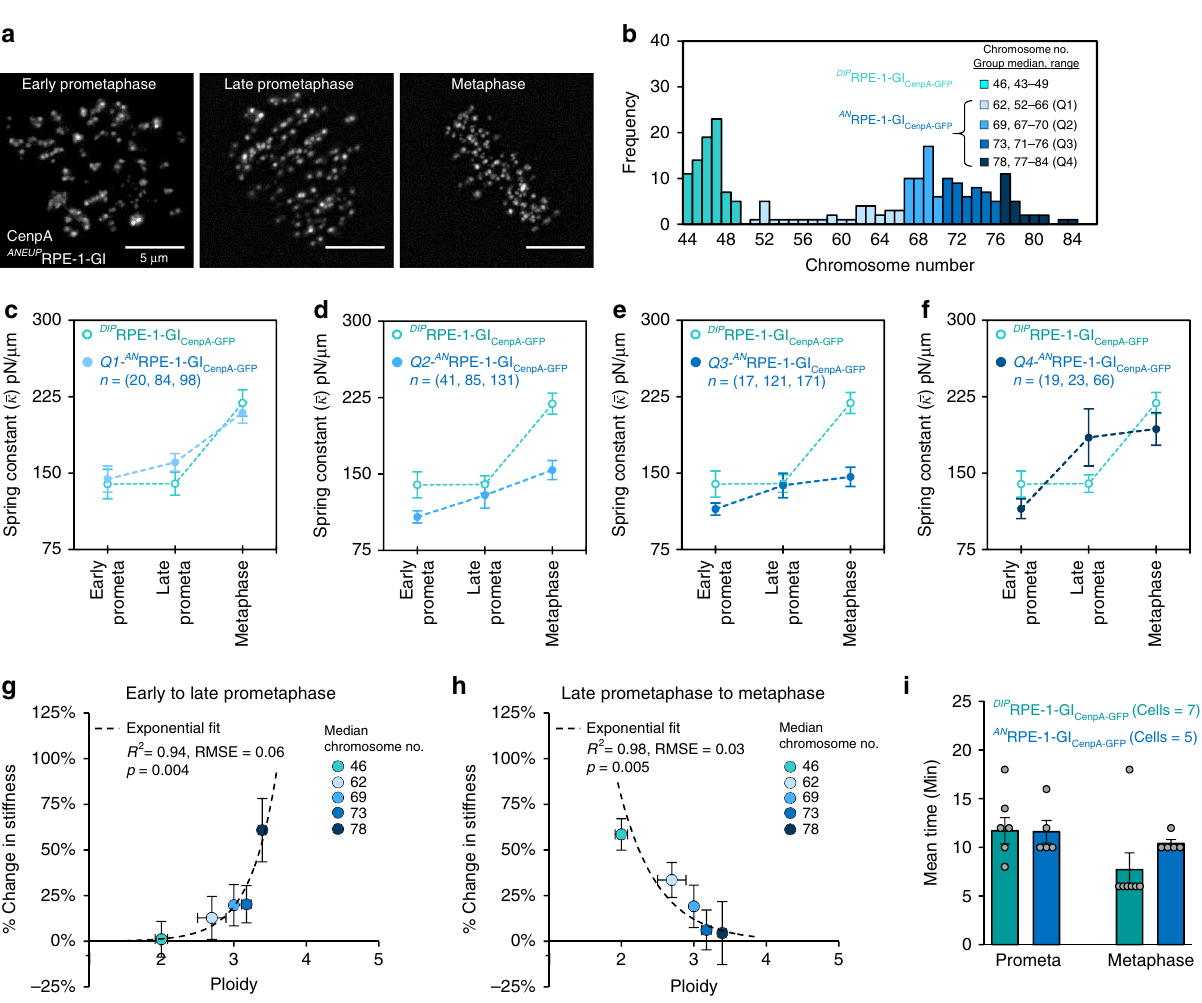
= 48, n Ce = 80, n Ce = 110). c – f Mean M eP lP